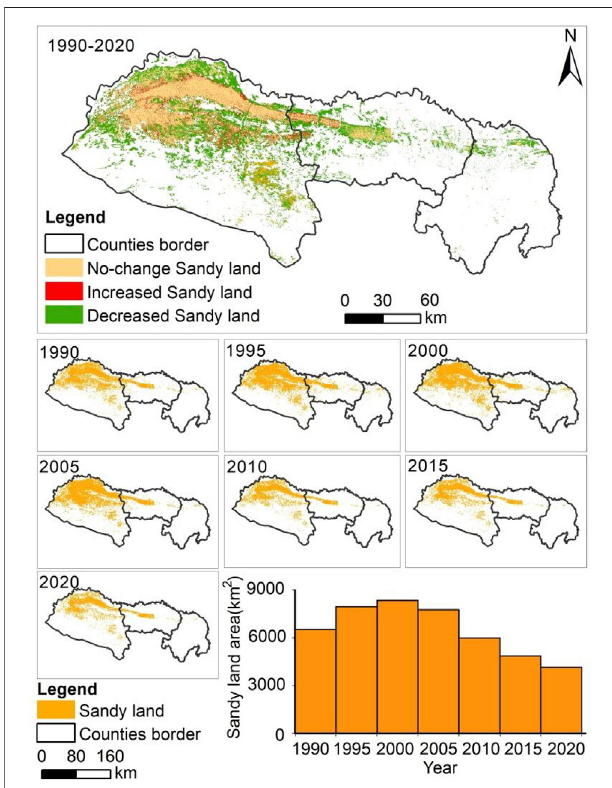
FIGURE 5 | Spatio – temporal pattern of the Kubuqi Desert that evolved from 1990 to 2020.